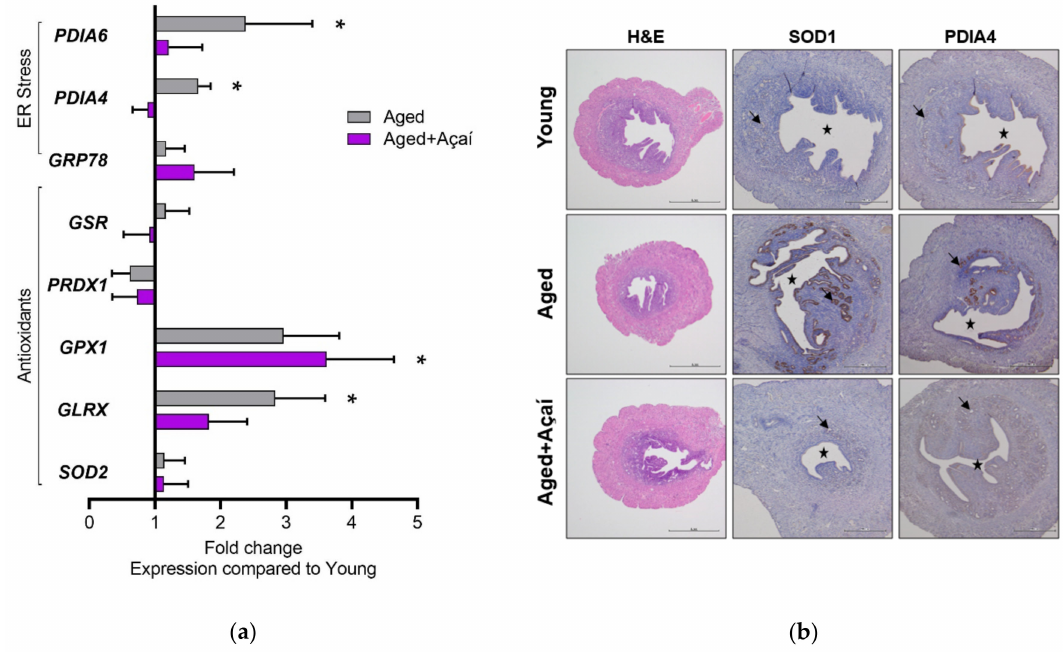
Figure 6. Uterine gene and protein expression. ( a ) Uterine tissue gene expression presented as a fold change compared to young mice (n = 10 per group). ( b ) Protein expression of SOD1 and PDIA4 in uterine tissue by immunohistochemistry. The black arrows point to glandular epithelium; the stars indicate the lumen surrounded by the luminal epithelium (n = 5 per group). Scale bars: 1 mm for the HE images and 500 µ m for the IHC images. The gene expression data were analyzed by ordinary one-way ANOVA with Tukey’s multiple comparisons when the overall effect p < 0.05. * p < 0.05 compared to young